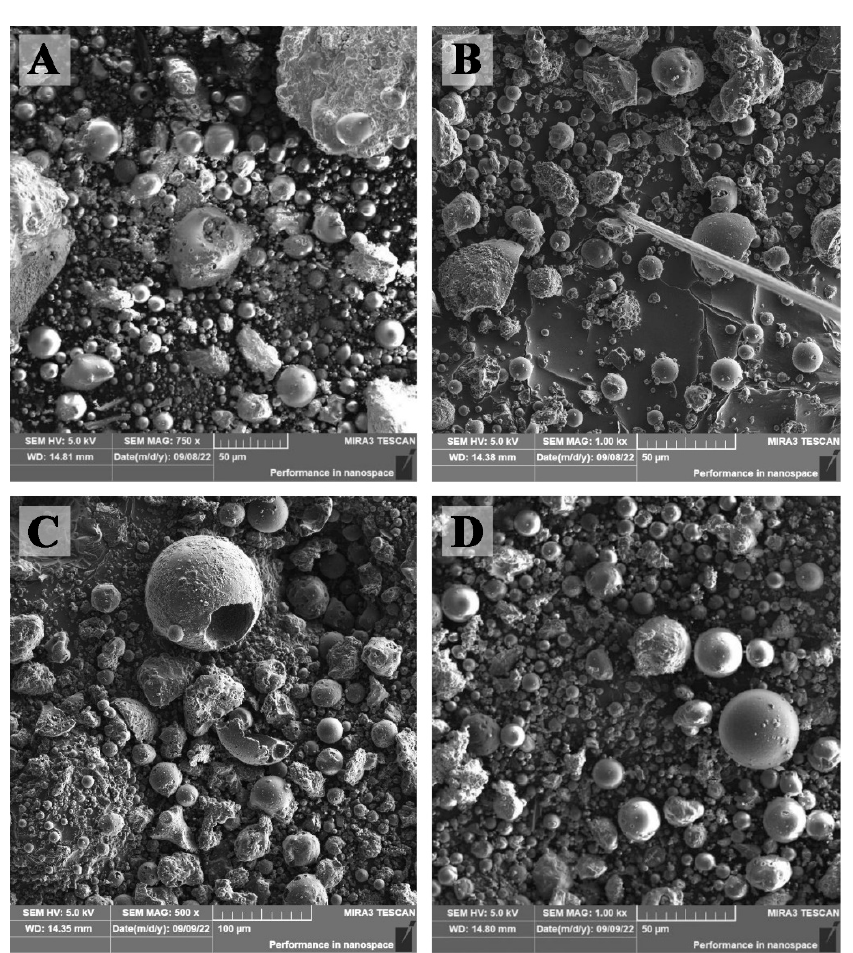
Figure 3. SEM micrographs of the milled and unmilled fly ash. ( A ) Ball-milled 30 min, ( B ) ball-milled 60 min, ( C ) attrition-milled, ( D )